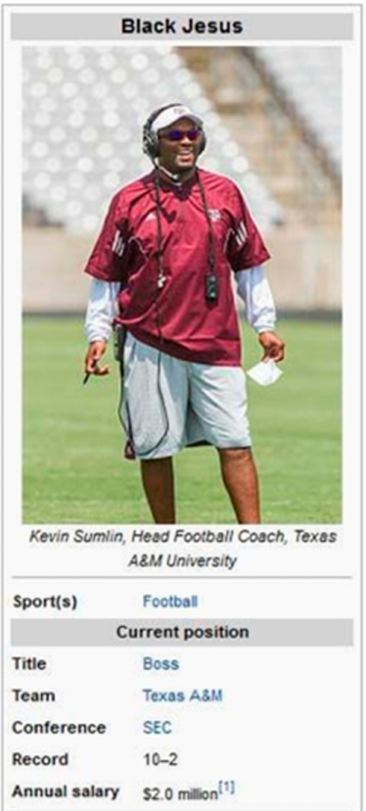
Figure 6. Texas A&M Head Football Coach, Kevin Sumlin. Screenshot taken from Sumlin’s Wikipedia